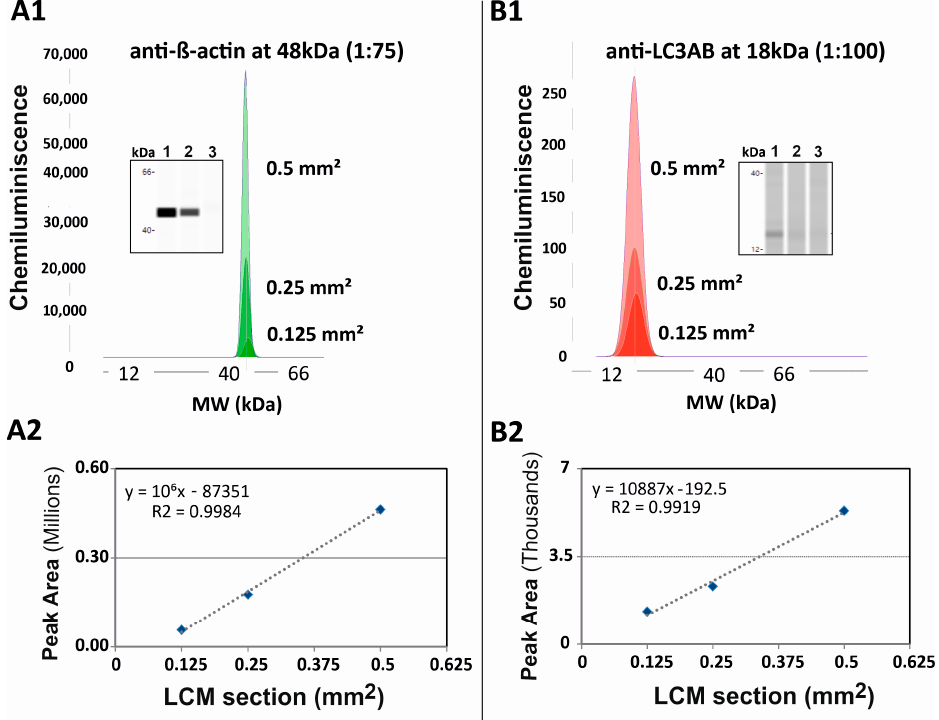
Figure 2. Cap-IA results of anti- β -actin (1:75) and anti-LC3AB (1:100) antibodies with three different LCM samples (0.5 mm 2 , 0.25 mm 2 , and 0.125 mm 2 ) of rat kidney tissue. ( A1 ) Electropherogram representation of cap-IA signals and gel-like image representation of cap-IA signals. Lane 1: 0.5 mm 2 ; lane 2: 0.25 mm 2 ; lane 3: 0.125 mm 2 using anti- β -actin antibody. ( B1 ) Electropherograms representation of cap-IA signals and gel-like image representation of cap-IA signals. Lane 1: 0.5 mm 2 ; lane 2: 0.25 mm 2 ; lane 3: 0.125 mm 2 using anti-LC3 antibody. ( A2 , B2 ) Linear curve of areas under peaks in cap-IA ( y -axis) versus loading protein amounts ( x -axis) relationship showing decreasing intensities of bands or peak areas with a decreasing area of LCM samples.